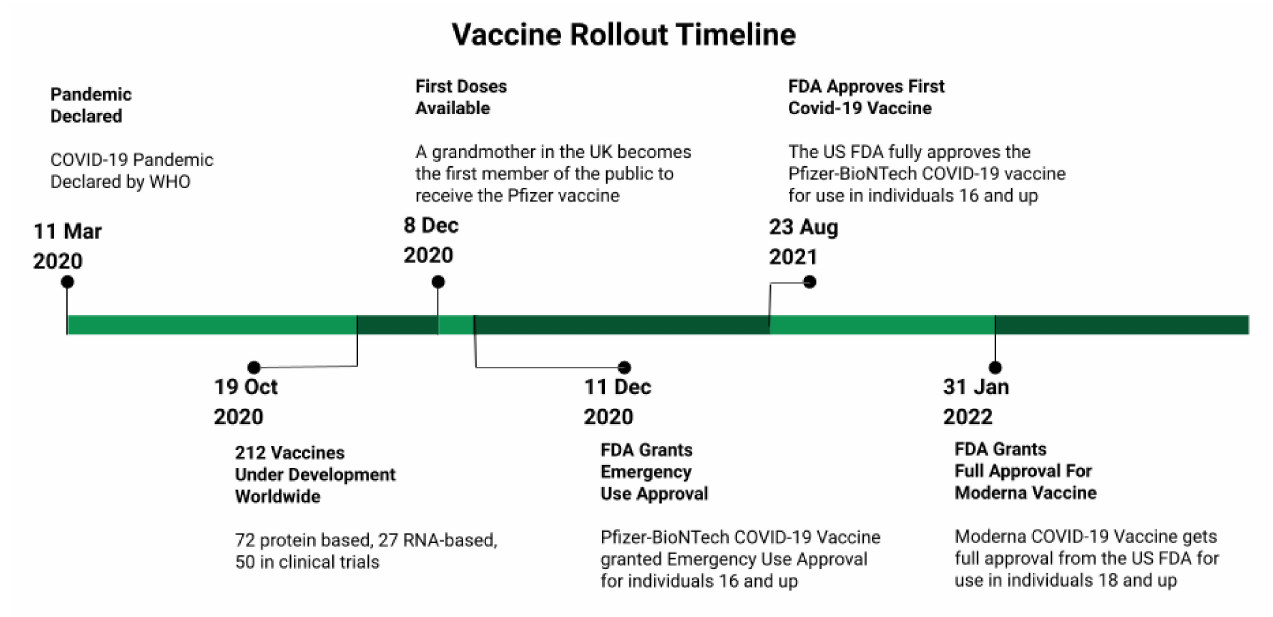
Figure 1. A brief timeline of selected events related to the vaccine